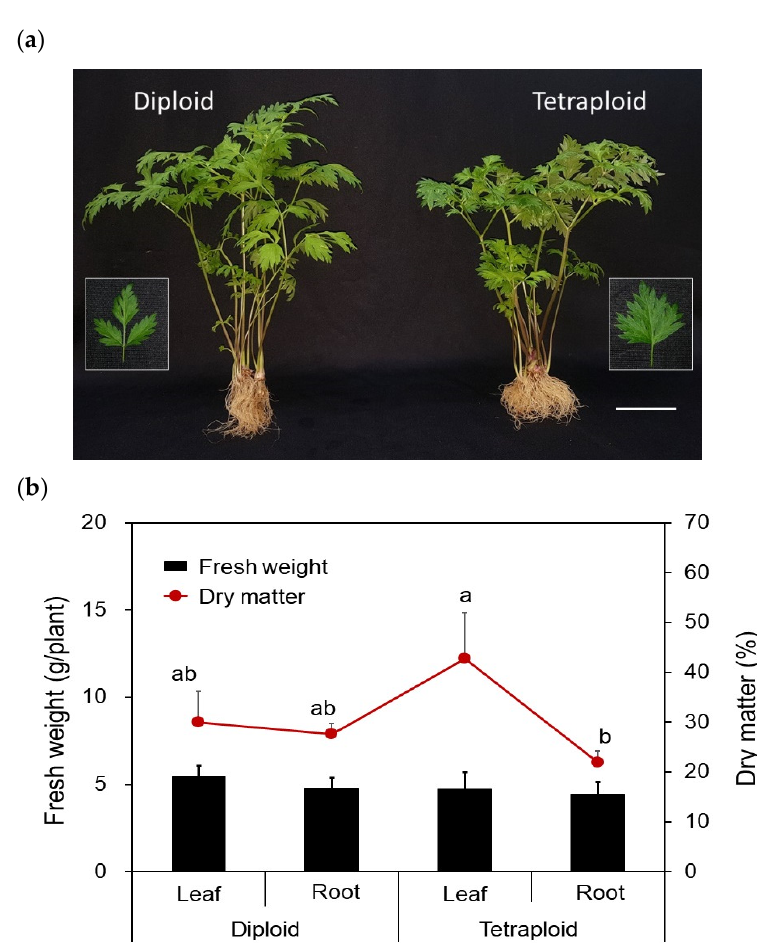
Figure 2. Phenotypic and quantitative analysis of the growth of diploid and tetraploid (line 81-12) in C. officinale . ( a ) Morphology of diploid and tetraploid plants. Scale bar = 5 cm. ( b ) Fresh weight and dry matter content of diploid and tetraploid plants. Data represent mean ± SE. Different lowercase letters indicate significant differences ( p < 0.05; Duncan’s multiple range test). Table 2. Measurements of the morphological traits of diploid and tetraploid (line 81-12) ex vitro- grown C. officinale plants.